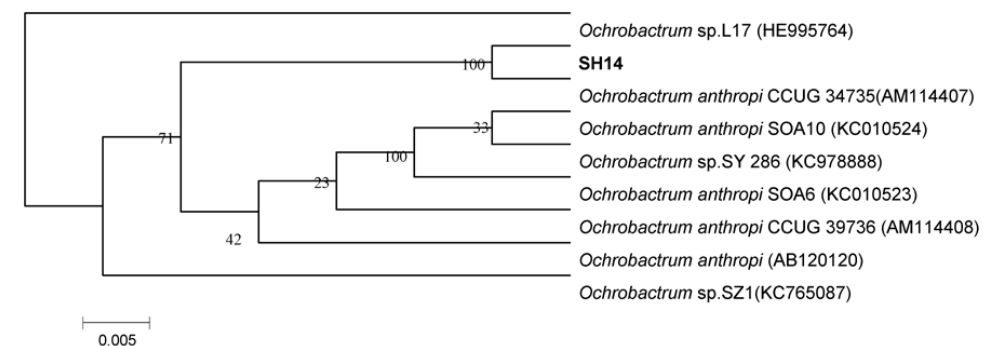
Figure 2. Phylogenetic tree based on 16S rRNA sequence of strain SH14 and related strains. The neighbor-joining method (NJ) was used to construct the phylogenetic tree. Numbers at the nodes show bootstrap values from the neighbor-joining analysis of 1000 resampled data sets. Dates in parentheses are the GenBank sequences accession numbers. Bar refers to sequence divergence.